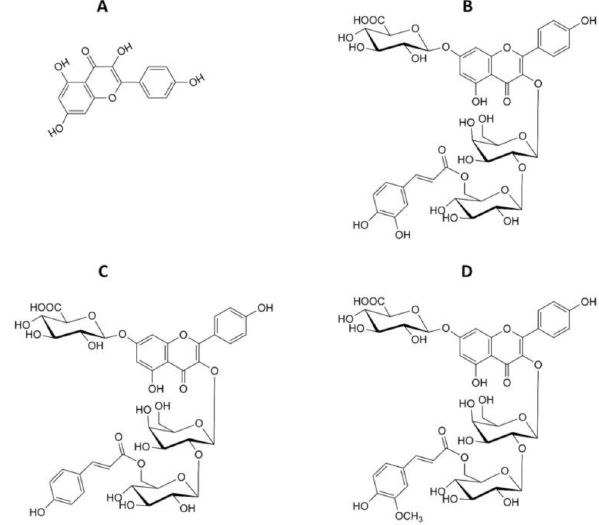
Figure 1. Chemical structures of kaempferol and its derivatives isolated from Lens culi- naris